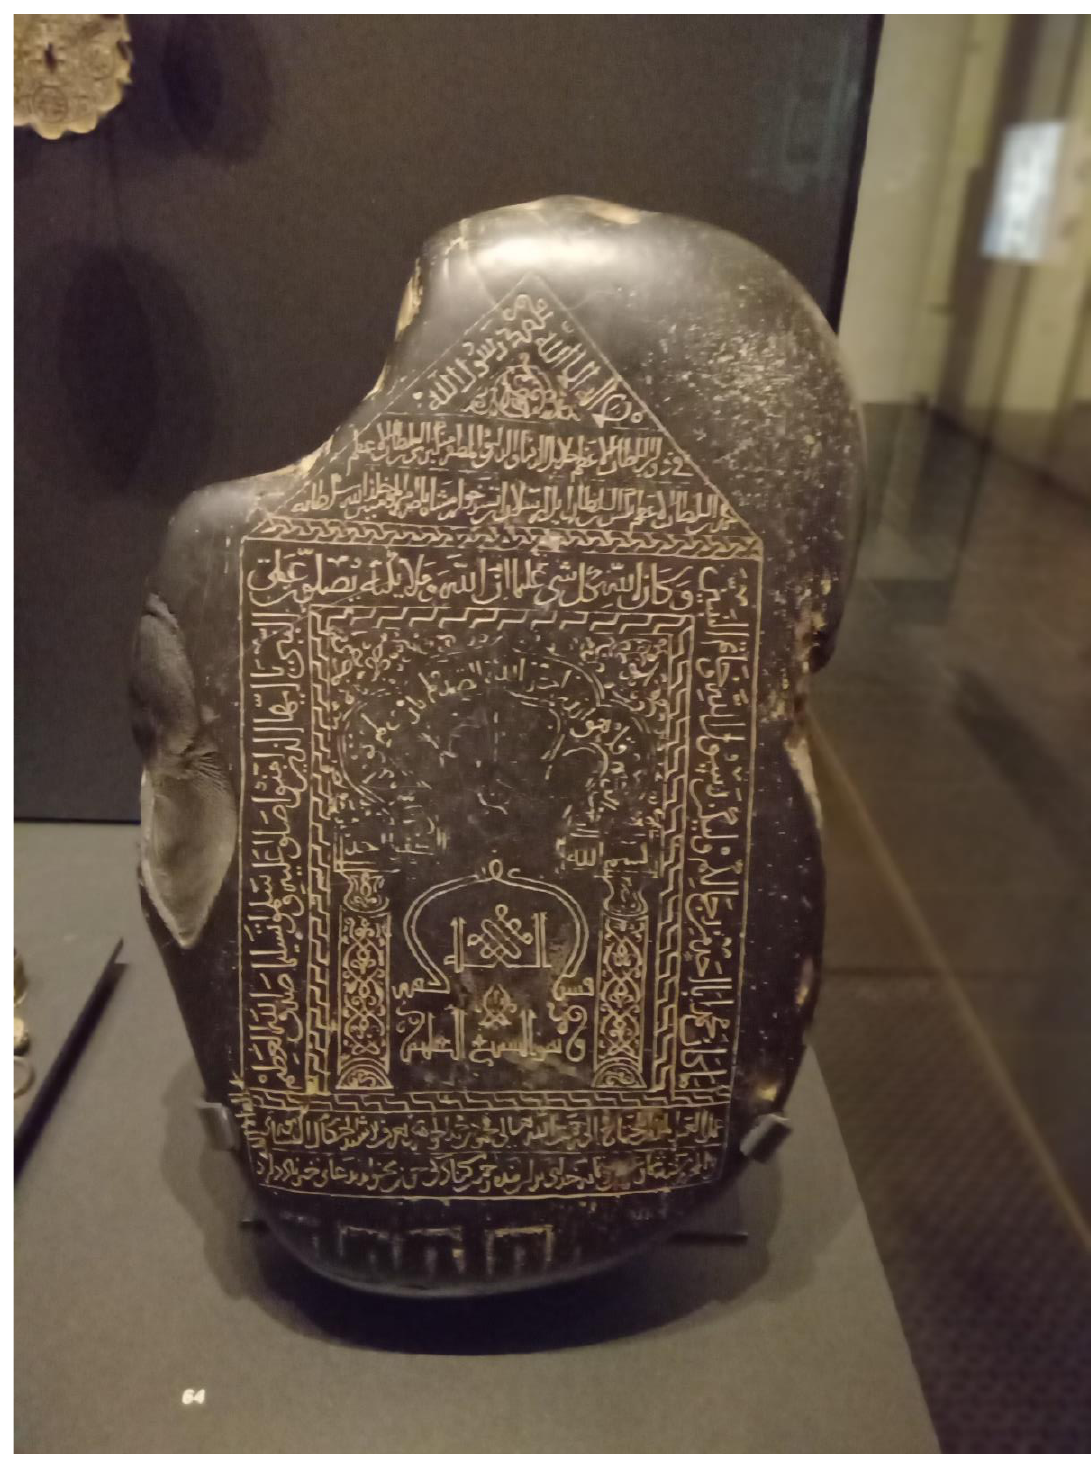
Figure 5. Stone inscribed with the name of the Khwarazmshah Jalal al-Din Mangubirti, and engraved with a representation of mihrab, with Quranic inscriptions. Nishapur, Historic Iran, 1230. Albukhary Gallery, British Museum. Photo of the author.